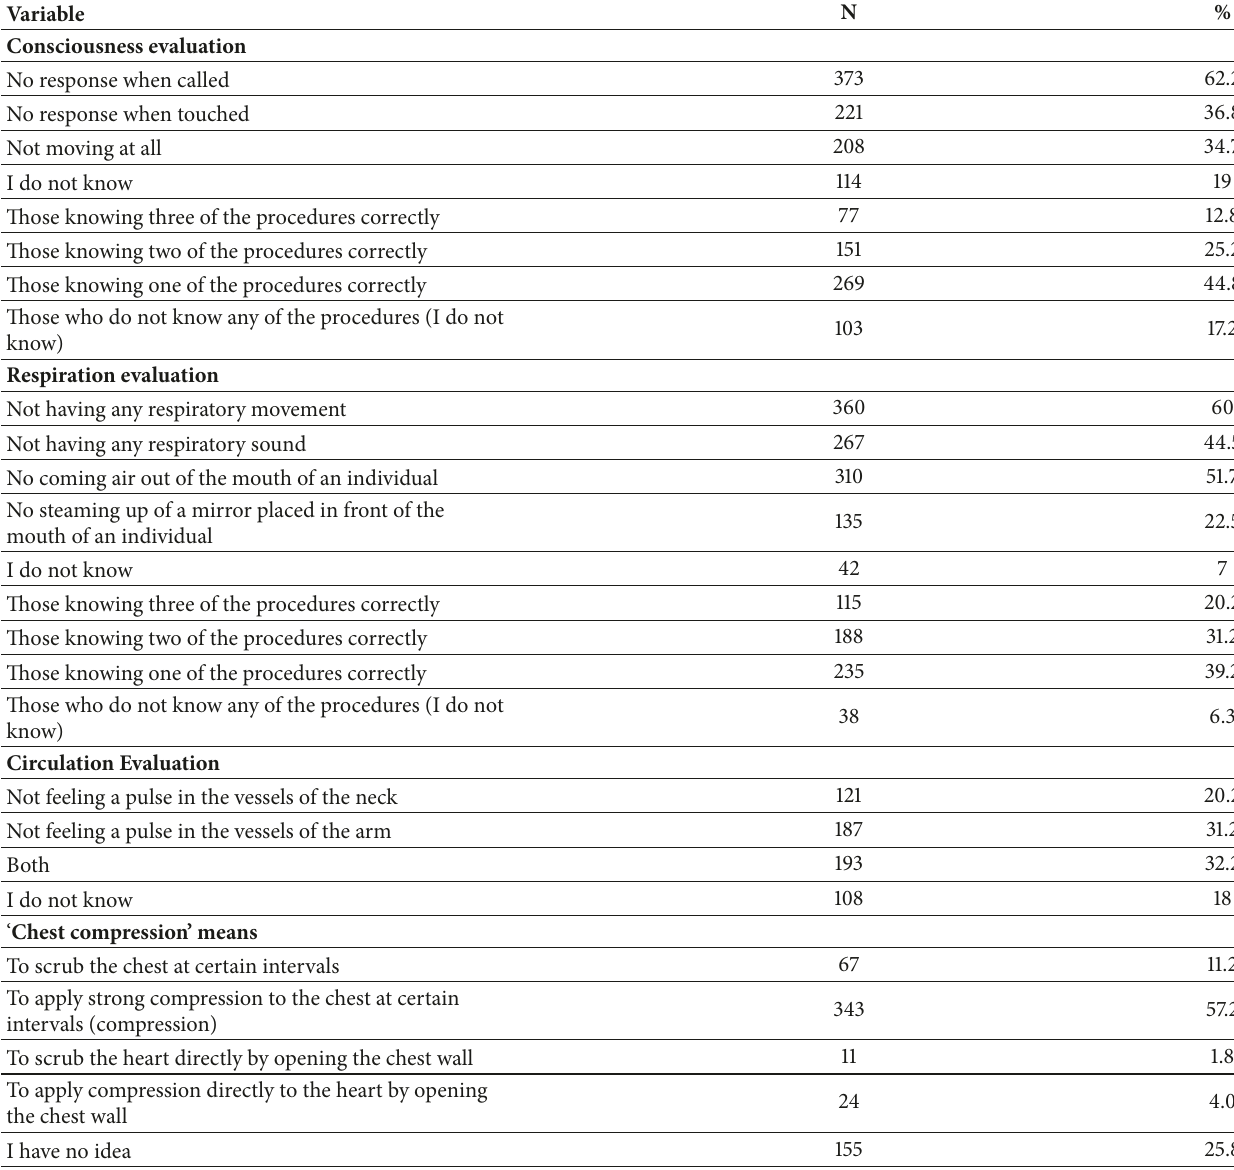
Table 3: Identification of cardiac arrest